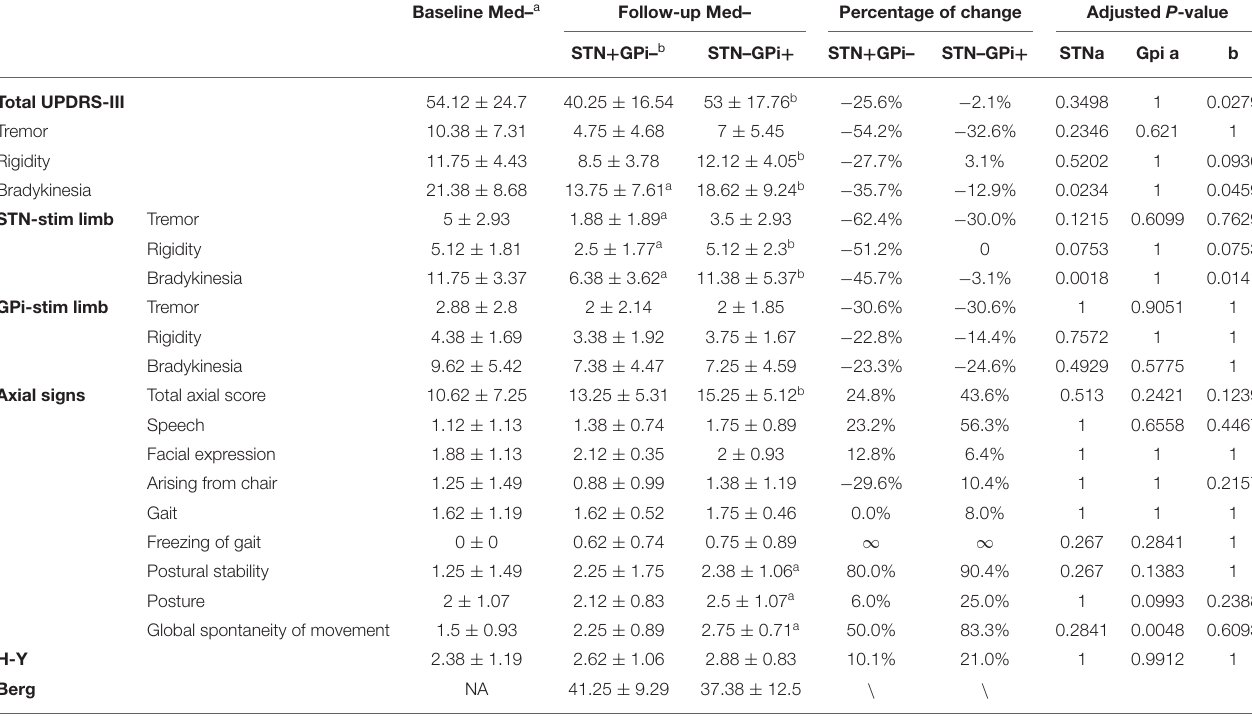
TABLE 2 | Motor symptoms in Med–STN + GPi– and Med–STN–GPi + conditions before and 2 to 3 years after surgery ( n =